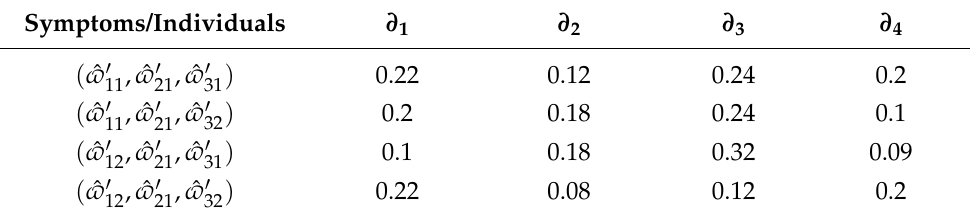
Table 9. Scores in the form of FHS